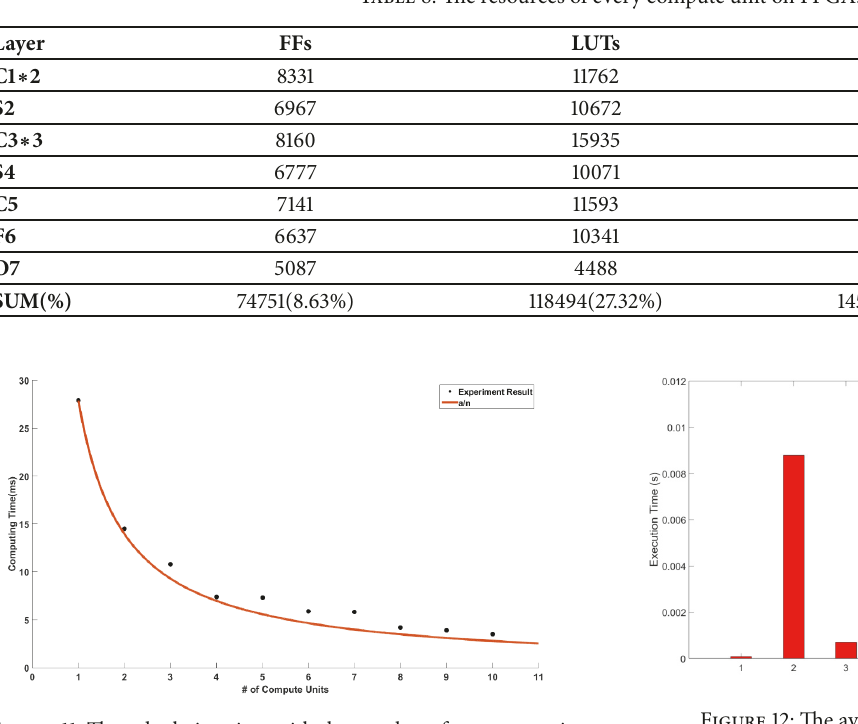
Figure 11: The calculation time with the number of compute units. Figure 12: The average running time of every event.